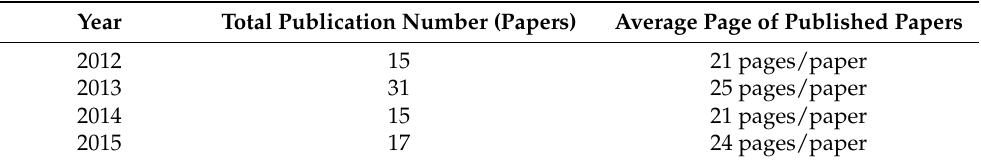
Table 1. JSAN maintained a relatively high standard to control the quality of received research as one could see from the data below.